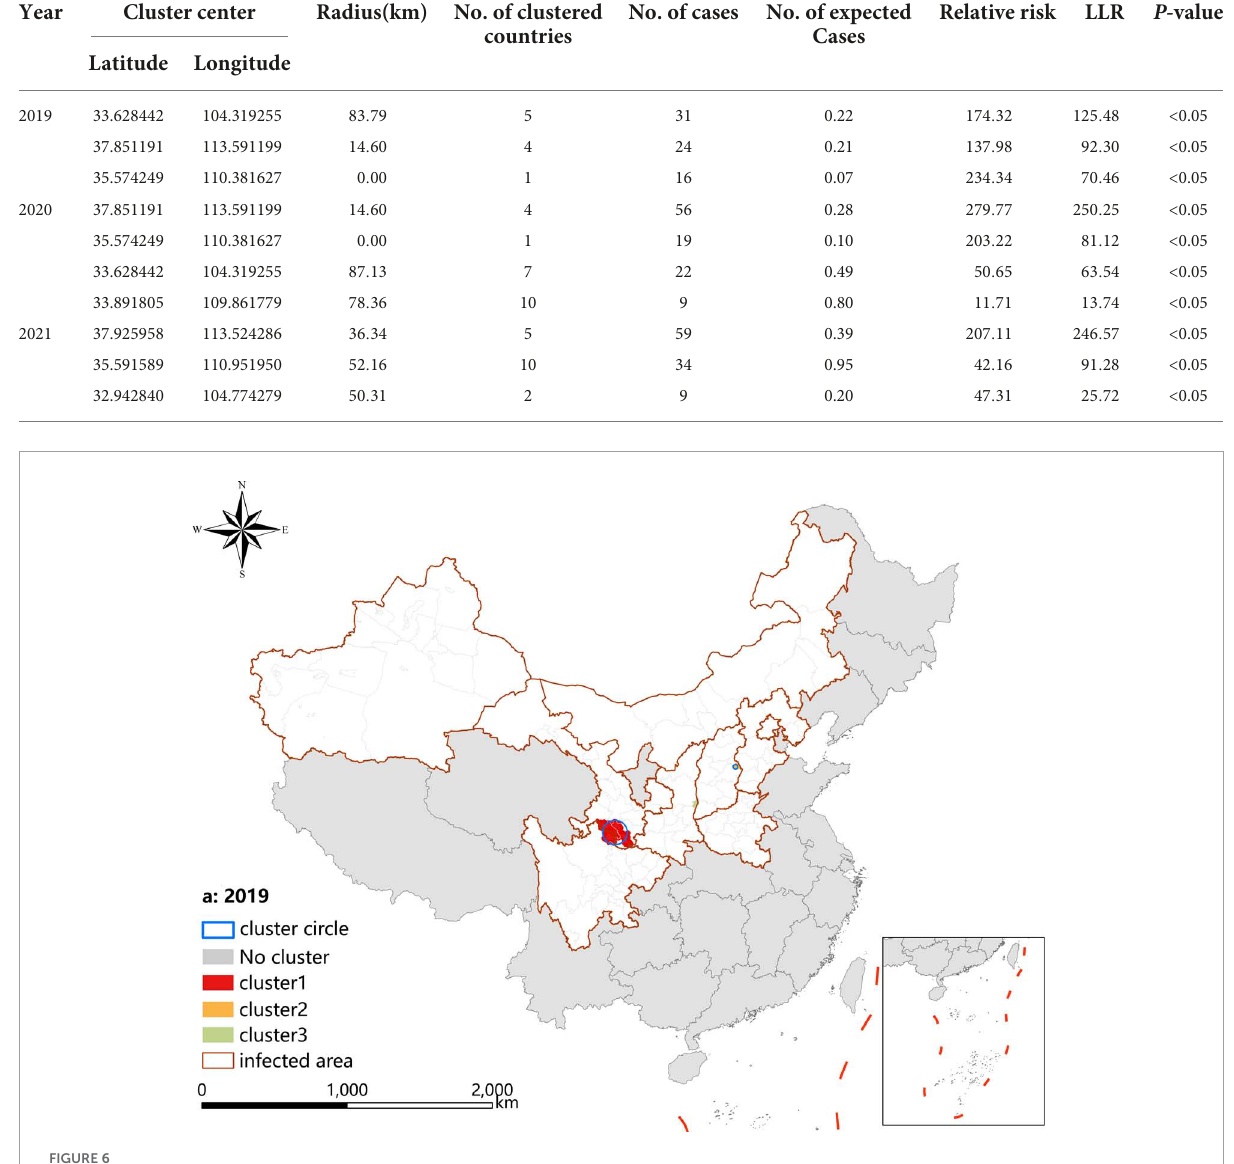
FIGURE6 Spatio-temporal clustering analysis of visceral leishmaniasis incidence in mainland China in